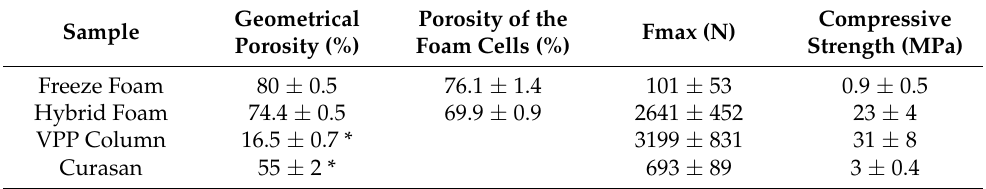
Table 2. Compressive strength of manufactured components (foams, hybrids, and columns).